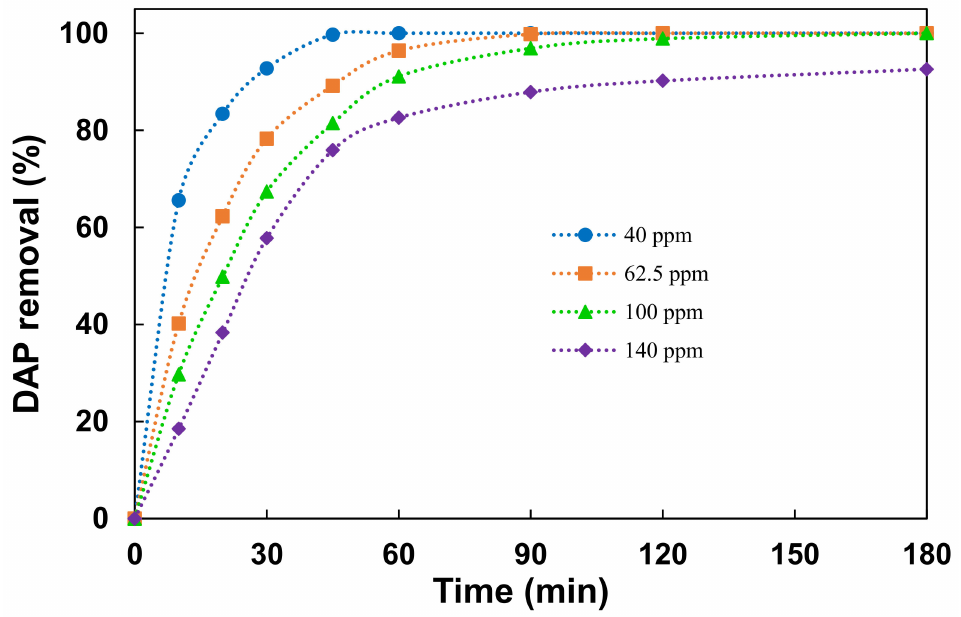
Figure 6. Effect of initial DAP concentration on the DAP degradation kinetics during the Fenton process (H 2 O 2 /Fe 2+ ). Experimental conditions: [DAP] 0 = 40–140 mg/L; [H 2 O 2 ]/[DAP] = 10; [H 2 O 2 ]/[Fe 2+ ] = 20 pH =